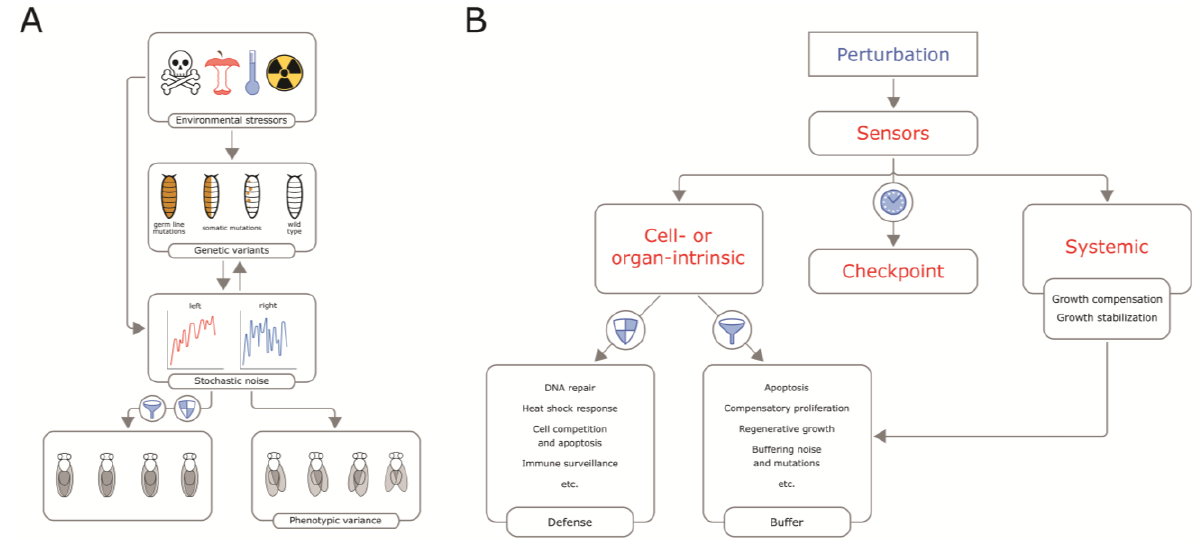
FIGURE 1 : A speculative model of the three sources of perturbation and their interactions in generating intra- and interindividual phe- notypic variability, illustrated in flies. (A) Drosophila larvae may acquire mutations that can be expressed in a mosaic state (brown dots) or inherited from one of the parents (all brown). Stochastic noise may cause gene expression fluctuations and variability in growth be- tween the left and right sides. Environmental factors may cause changes in gene expression by genetic and non-genetic effects. Biological noise can cause replication errors that result in mutations e.g. [61] and thus it may also contribute to somatic mutations. (B) Develop- mental robustness requires mechanisms that sense damage and growth perturbations inflicted at the cell, organ, and systemic level. Specific damage sensors activate coordinated responses that trigger checkpoints such as transcriptional or cell cycle arrest to provide time for repair or to counterbalance perturbations (e.g., during a thermal stress). When damage is unrepairable, cellular stress sensors also initiates the apoptosis of the damaged cells. To maintain tissue growth and homeostasis, stress sensors such as p53 trigger compen- satory proliferation. Massive tissue damage activates local regenerative responses and trigger a checkpoint that delays developmental timing (maturation) and act systemically. In addition, a variety of surveillance mechanisms maintain tissue quality control by detecting and eliminating both less fit and potentially harmful